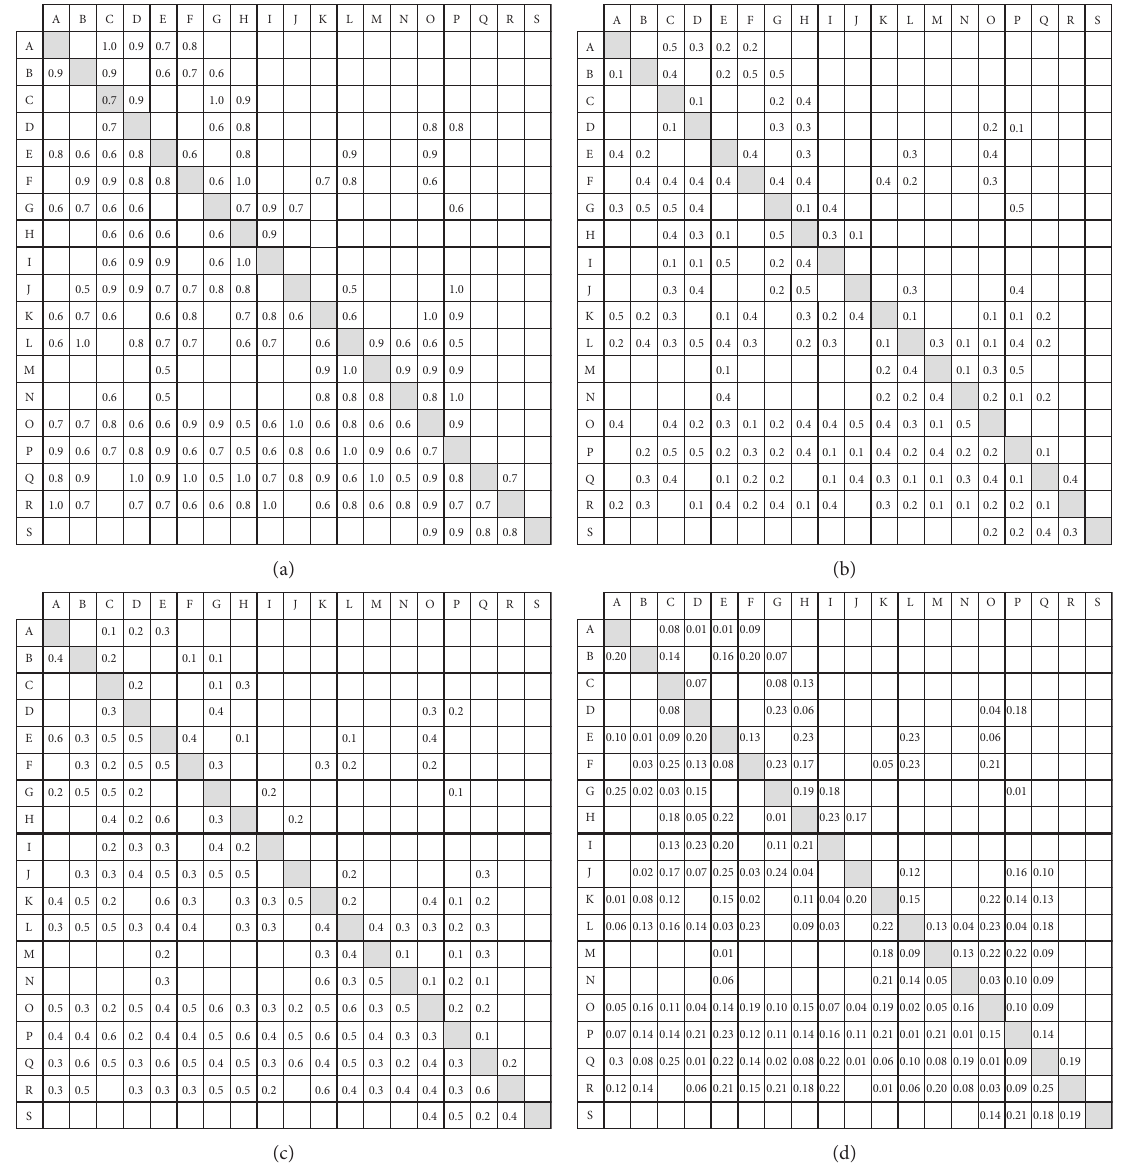
Figure 8: Project information initial matrices in the case project. (a) Matrix P